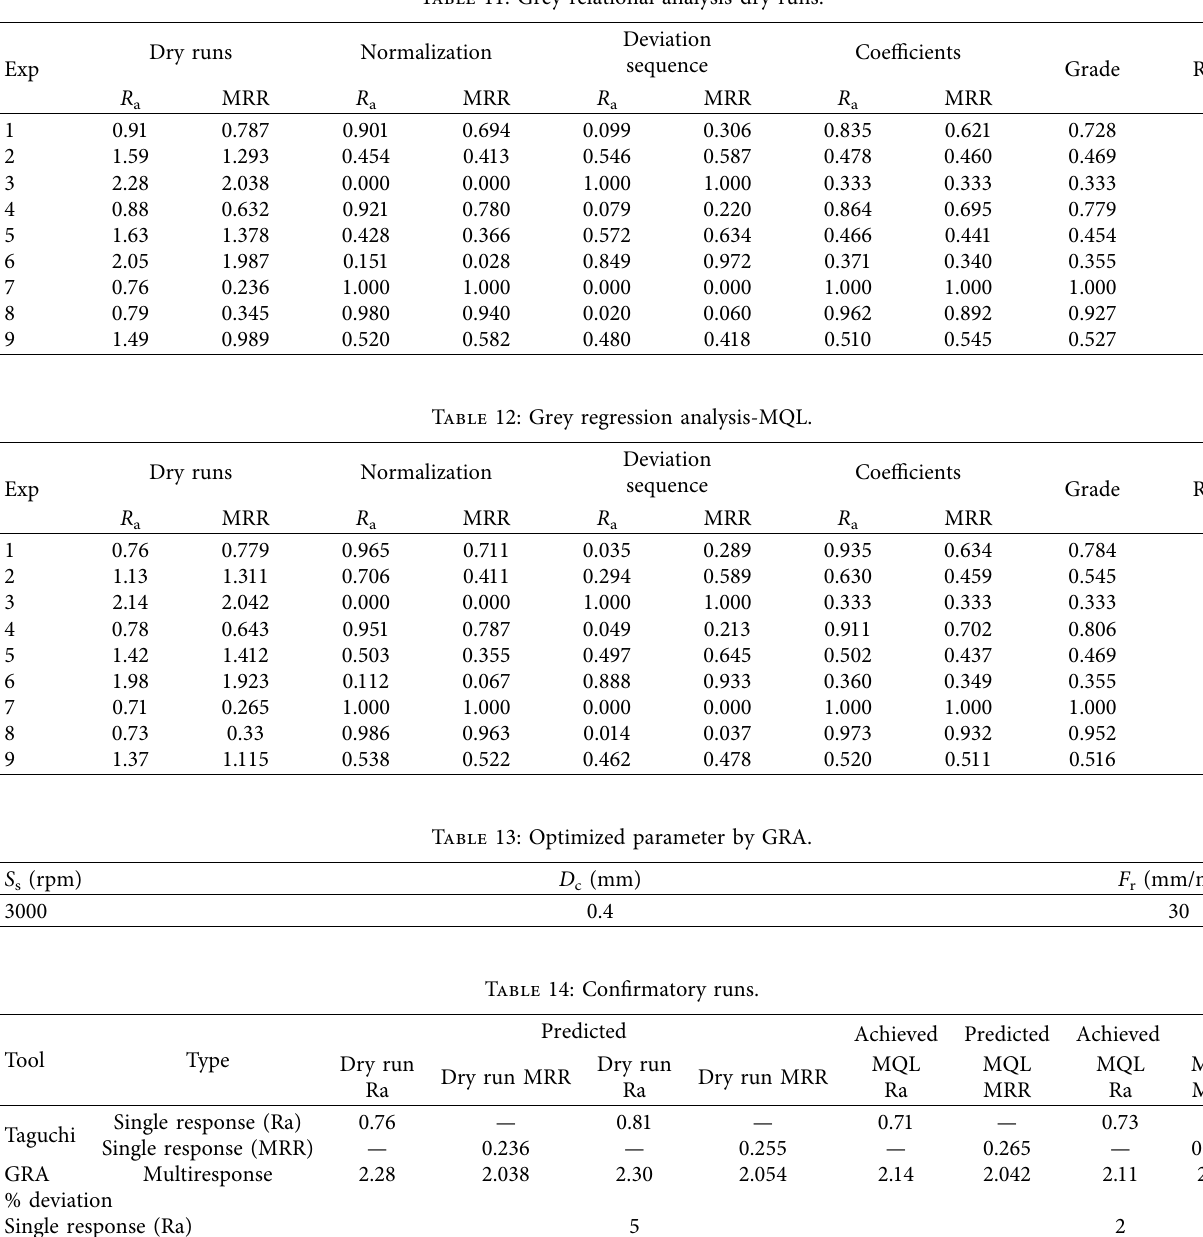
Table 11: Grey relational analysis-dry runs.